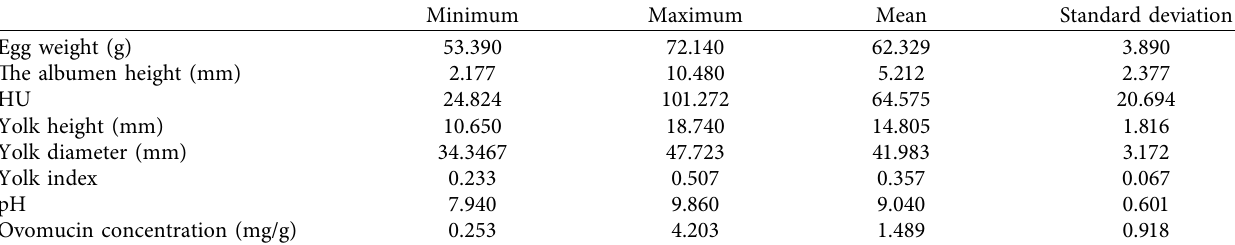
Table 1: Descriptive information and statistical results for egg freshness indicators and ovomucin concentration.